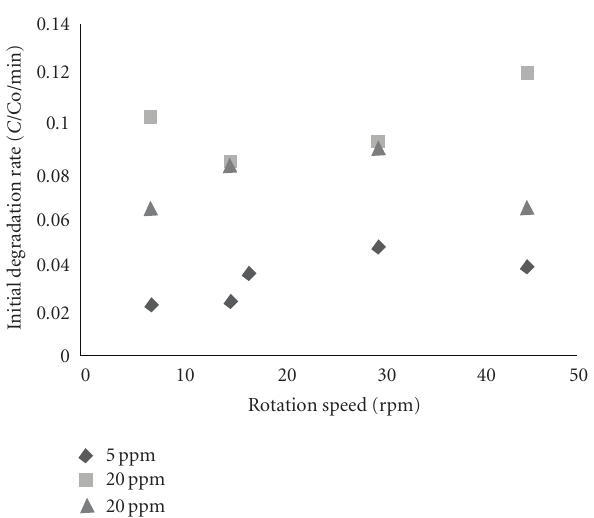
Figure 8: E ff ect of initial concentration on degradation rate for 28 fin drum.